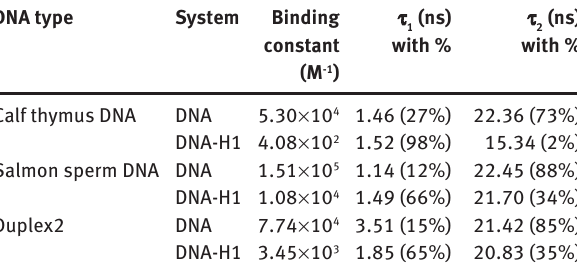
evident that the perturbation of EtBr-binding (change in 22 ns component) to the duplex2 upon complexation with DNA condensates. From Table 1, it is evident that the faster time constant ( < 3.5 ns) of EtBr in the duplex2 without H1 is slower than that in buffer (1.5 ns) and much faster Table 1 Picosecond-resolved fluorescence transients of ethidium in various DNAs and their condensates with H1.